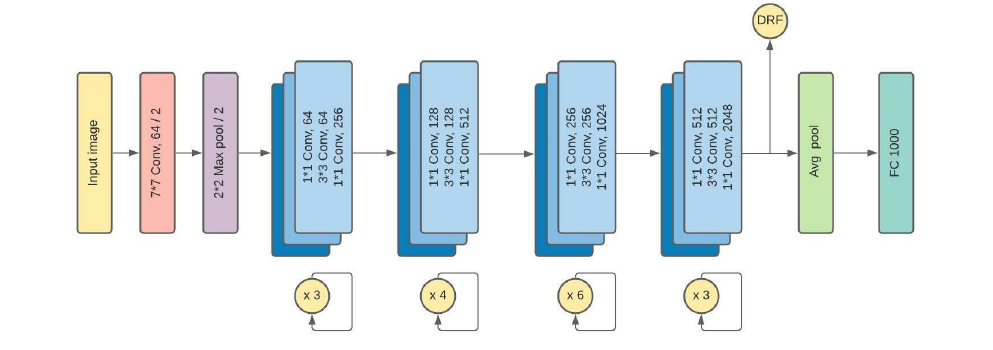
Figure 2. ResNet50